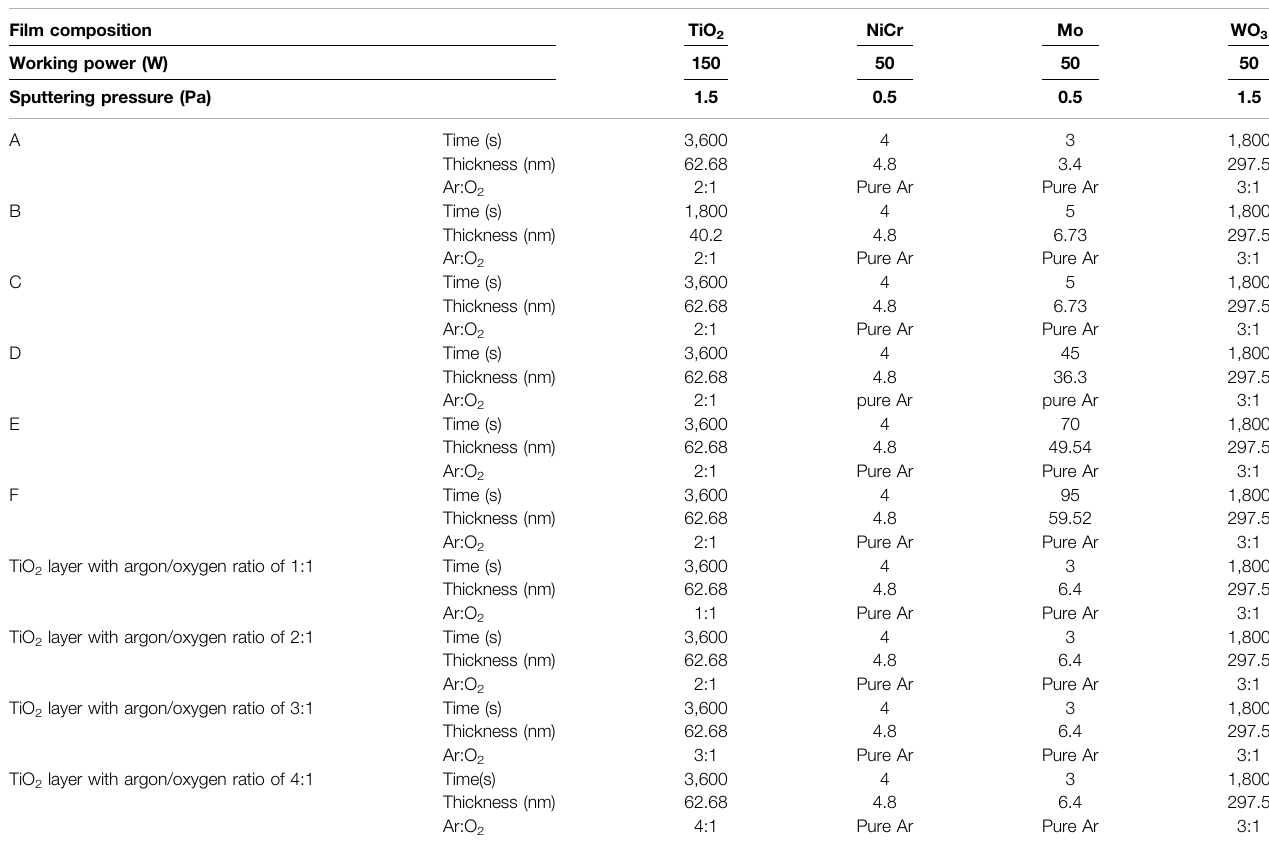
TABLE 1 | Deposition conditions of each layer to produce the multilayer fi